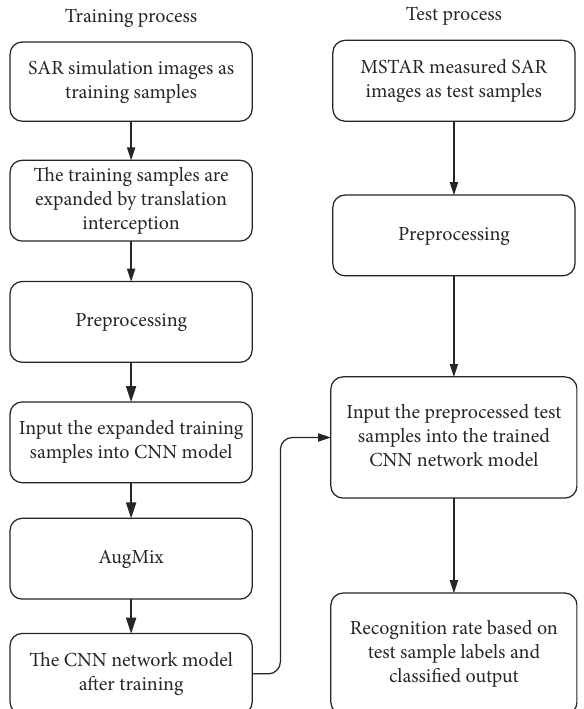
Figure 11: Influence of preprocessing on recognition